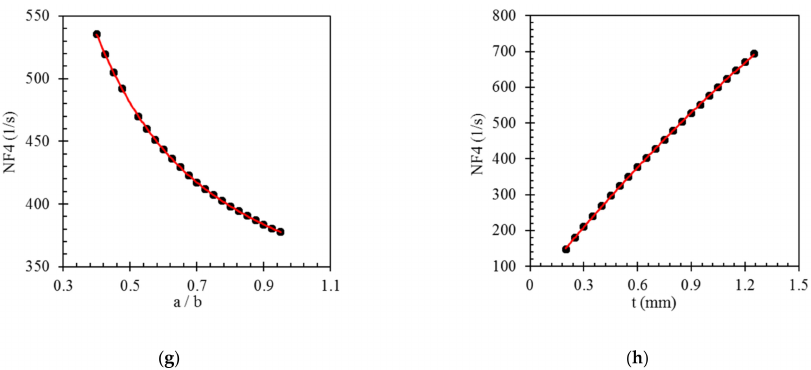
Figure 9. Results of the parametric studies on the inputs and output of the GP models. ( a ) the effect of a/b variation on NF1 ( b ) the effect of t variation on NF1 ( c ) the effect of a/b variation on NF2 ( d ) the effect of t variation on NF2 ( e ) the effect of a/b variation on NF3 ( f ) the effect of t variation on NF3 ( g ) the effect of a/b variation on NF4 ( h ) the effect of t variation on NF4.